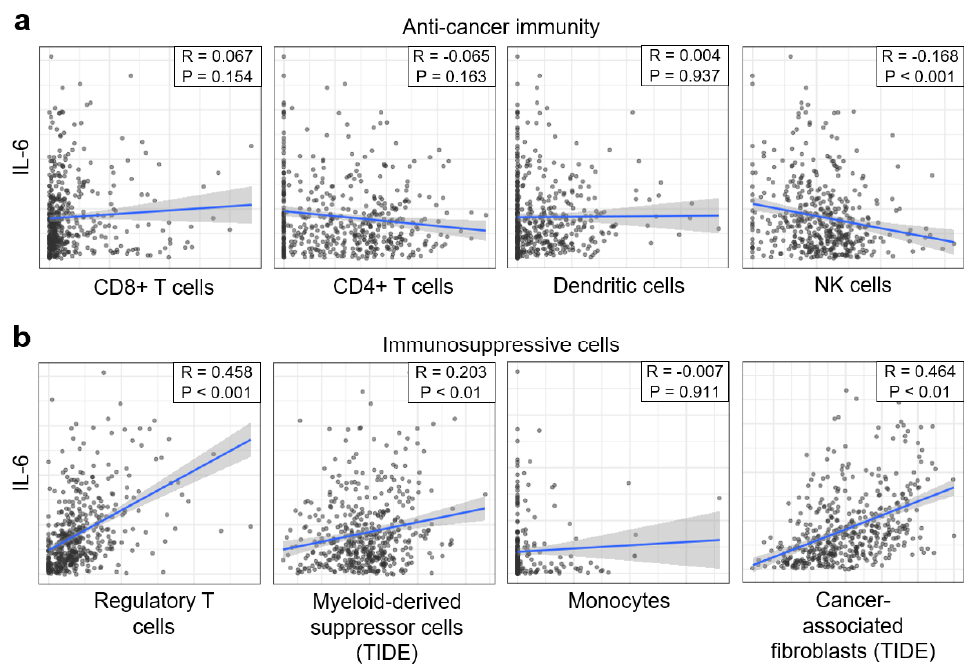
Figure 1. IL-6 levels are associated with tumor immunity in clear cell renal cell carcinoma. The correlations between IL-6 levels and immune cells or stromal cells were analyzed using clear cell RCC datasets ( n = 533) from The Cancer Genome Atlas. ( a ) Correlation plots of IL-6 levels with anticancer immune cells: CD8+ T cells, CD4+ T cells, dendritic cells, and natural killer cells. ( b ) Correlation plots of IL-6 levels with regulatory T cells, myeloid-derived suppressor cells, monocytes, and cancer- associated fibroblasts were generated using Pearson’s correlation. The blue solid lines represent the regression curve, and the shaded areas represent the 95% confidence interval bands of the best fit. TIDE, tumor immune dysfunction, and exclusion.